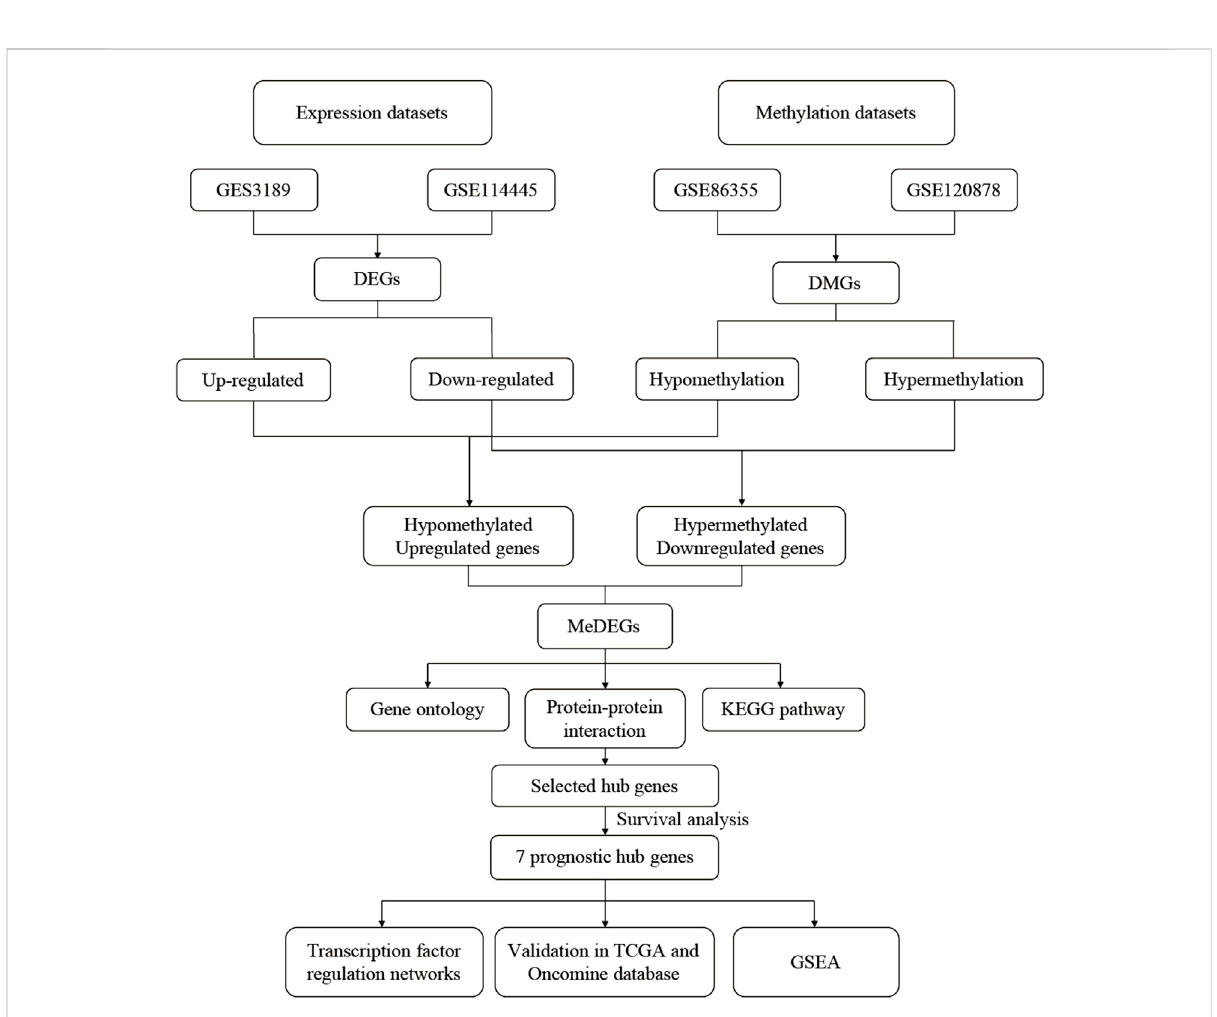
FIGURE 2 Flowchart of bioinformatics analysis. DEGs, Differentially expressed genes;DMGs, differentially methylated genes; MeDEGs, methylation- regulated differentiallyexpressed genes; KEGG, Kyoto Encyclopedia of Genes and Genomes; GSEA, gene setenrichment